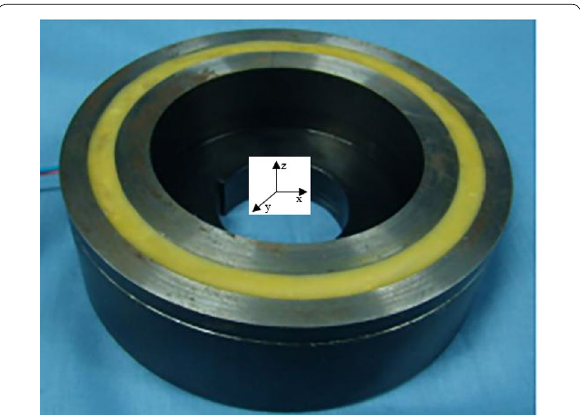
Figure 10 Prototyped